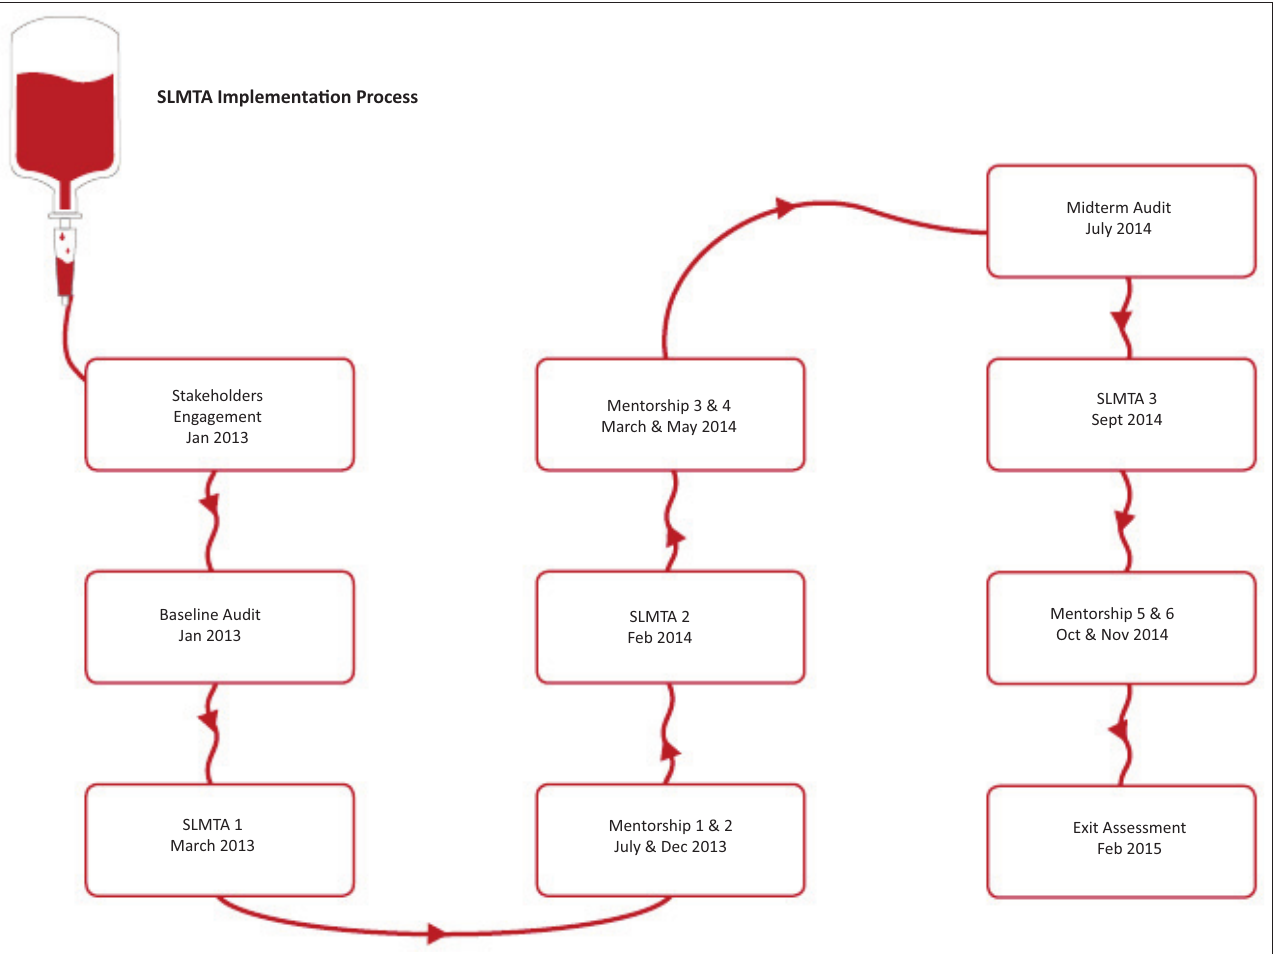
FIGURE 1: Kenya National Blood Transfusion Service SLMTA implementation